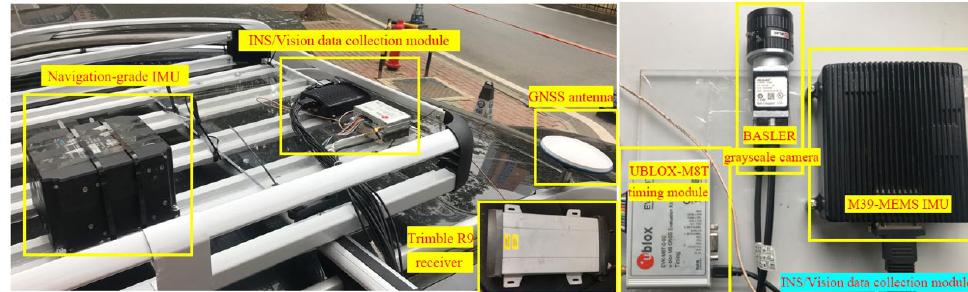
Figure 2. GNSS/INS/vision data collection platform.